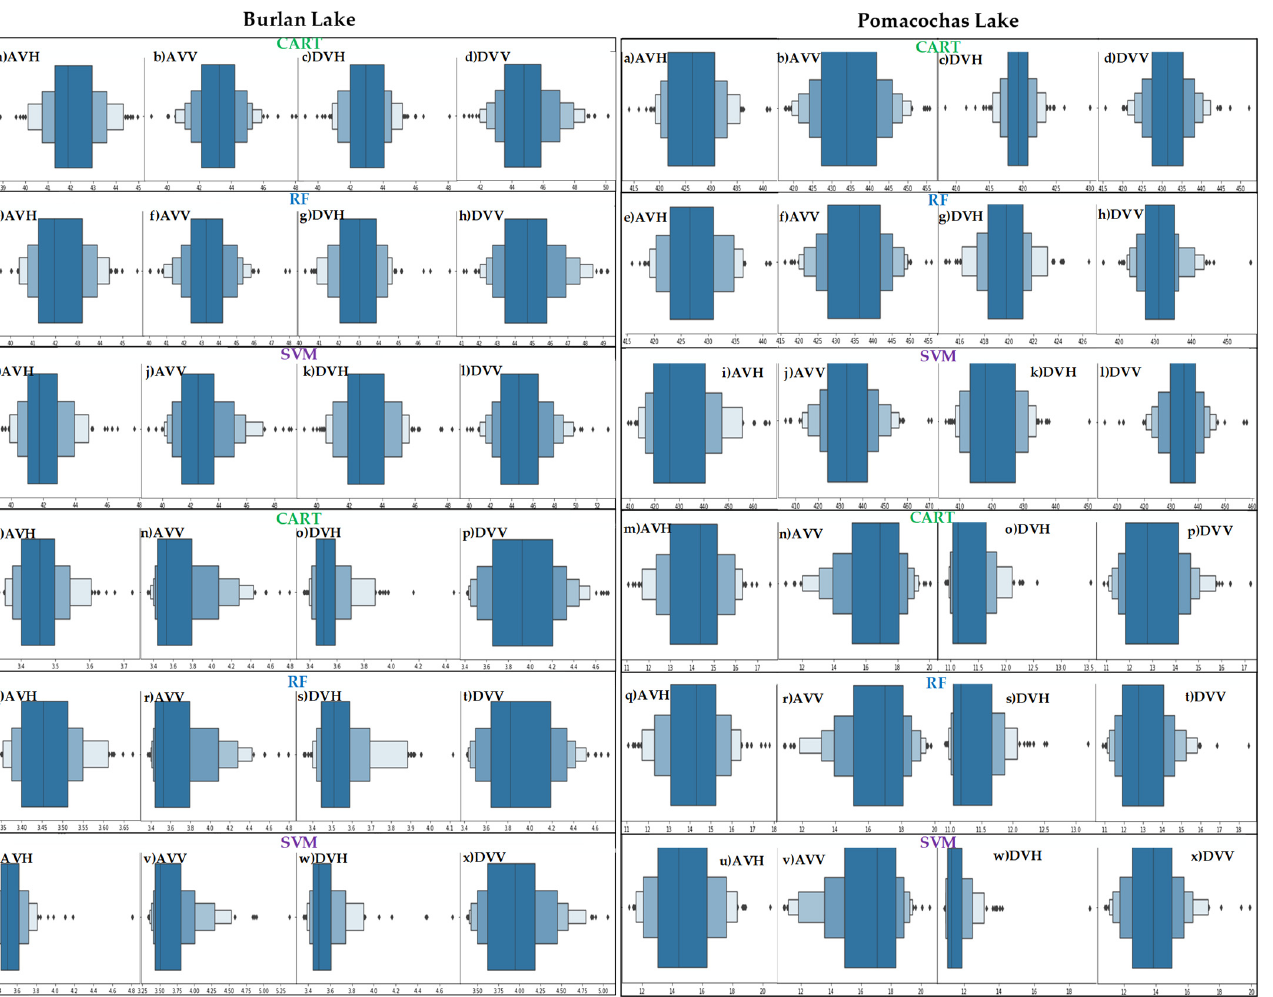
Figure 7. Dispersion of the area and perimeter data for Burlan and Pomacochas Lakes, where the black points represent outliers, and the rectangles represent the highest clustering of data according to quantiles.